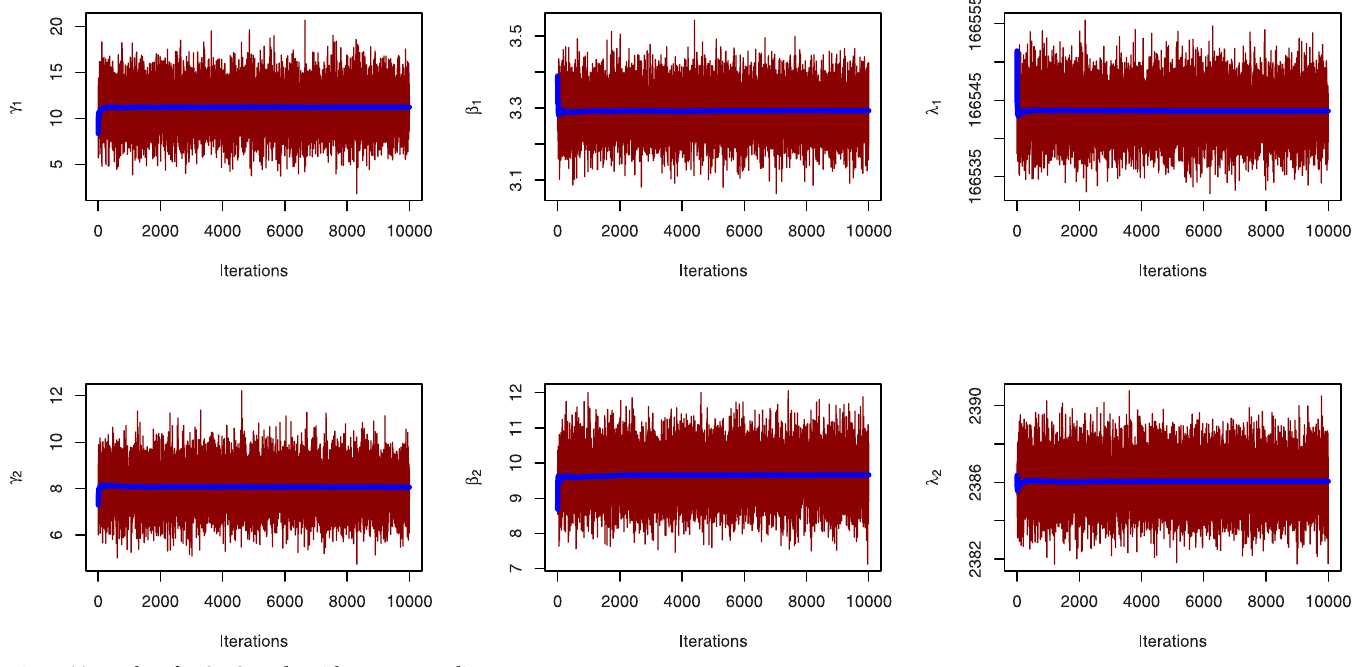
behavior of the estimators. Asymptotic confidence intervals of the likelihood estimation and highest posterior density of the Bayesian estimation are derived for the parameters of this model. Finally, the significance and adaptability of the BFGMPLx distribution are discussed by analyzing medical data related to the duration of diabetes and serum creatinine. Analyti- cal evaluations revealed that our BFGMPLx model had a satisfactory match when compared to other distributions.